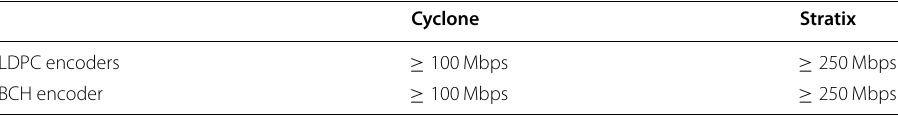
Table 7 Output bit rate achieved by hardware